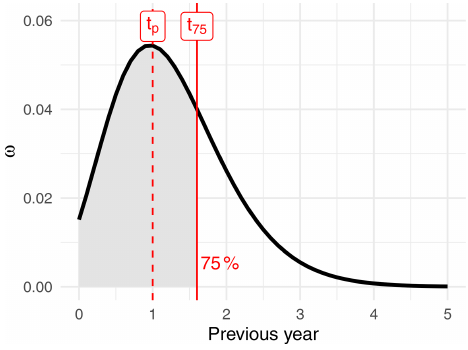
Figure 2. Extraction of two characteristic values from an example of a Gamma